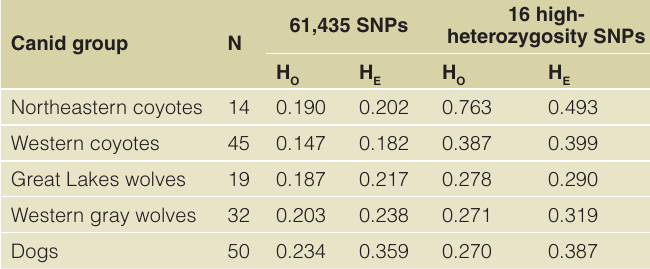
Table 3. Ascertainment bias of surveying genetic diversity in different groups of canids using SNPs discovered after completion of the dog genome